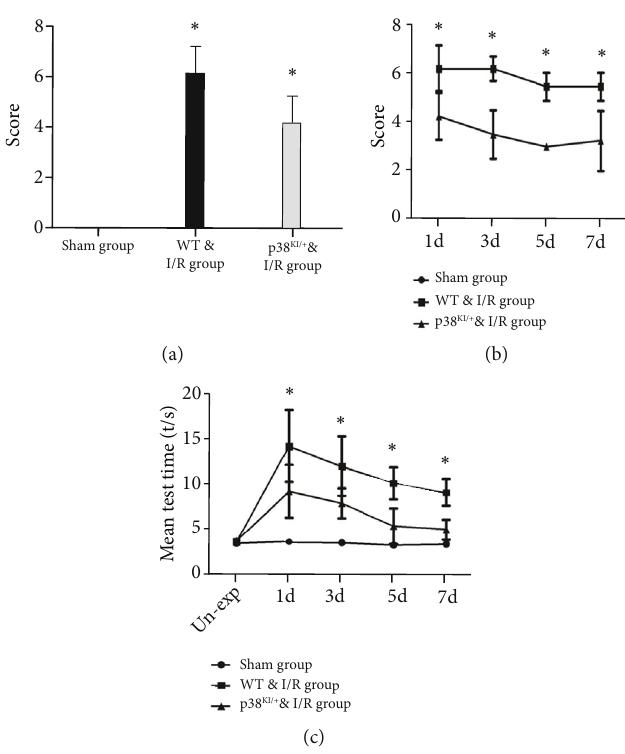
Figure 8: p38 MAPK knockdown improved neurobehavioral function. (a) Neurological severity score at 45 min after reperfusion in the mice of the p38 KI/+ & I/R group, the WT & I/R group, and the sham group; n = 3 per group; ∗ p < 0 : 05 , p38 KI/+ & I/R vs. I/R group. (b) Neurological de fi cit score at 1d, 3d, 5d, and 7 d after reperfusion in the mice of the p38 KI/+ & I/R group, the WT & I/R group, and the sham group; compared with the sham group, n = 3 per group, ∗ p < 0 : 05 , p38 KI/+ & I/R vs. I/R group. (c) The Virginia score after reperfusion was 1 day, 3 days, 5 days, and 7 days in the p38 KI/+ & I/R group, the WT & I/R group, and the sham group; mean test time re fl ects neurobehavioral function. n = 3 per group; ∗ p < 0 : 05 , sham group vs. I/R group; ∗ p < 0 : 05 , p38 KI/+ & I/R vs. I/R group. Un-exp represents to have no experiment. ∗ p < 0 : 05 by one-way